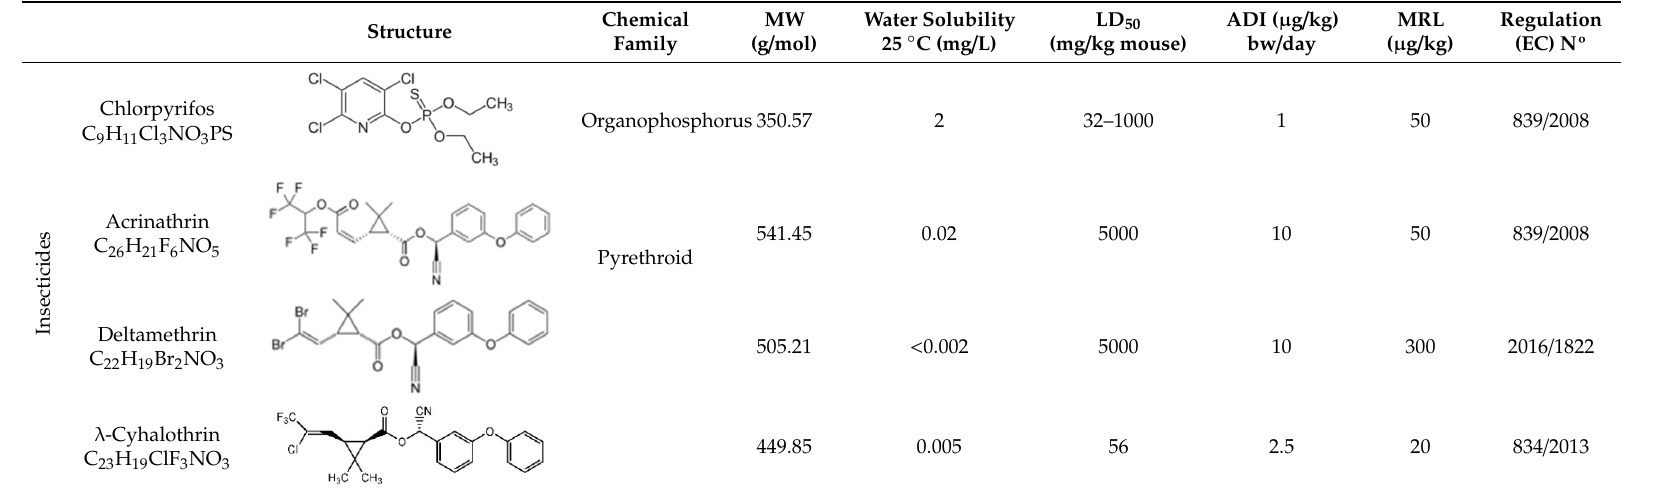
Table 1. Physicochemical parameters of the investigated